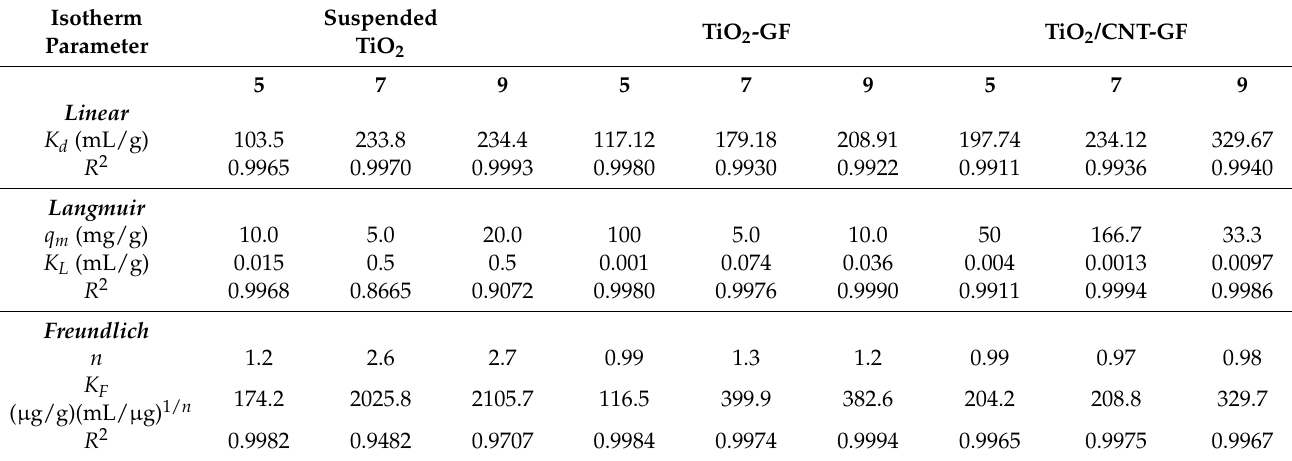
Table 7. Sorption isotherm parameters for CRZ as an influence of